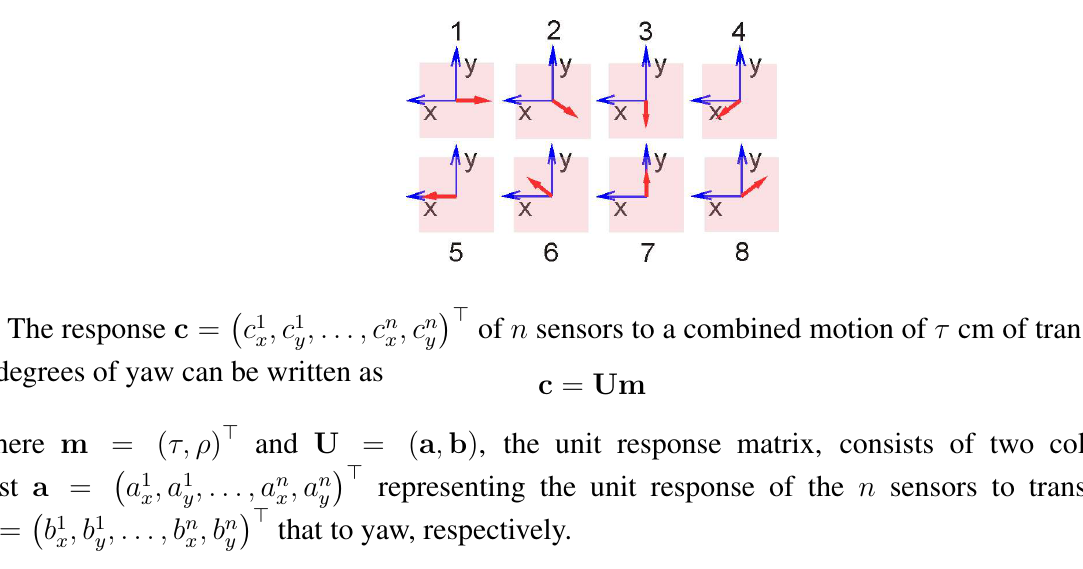
Figure 6. Sensors’ light sensitive area and expected flow pattern for sideways translation analogous to lower Figure